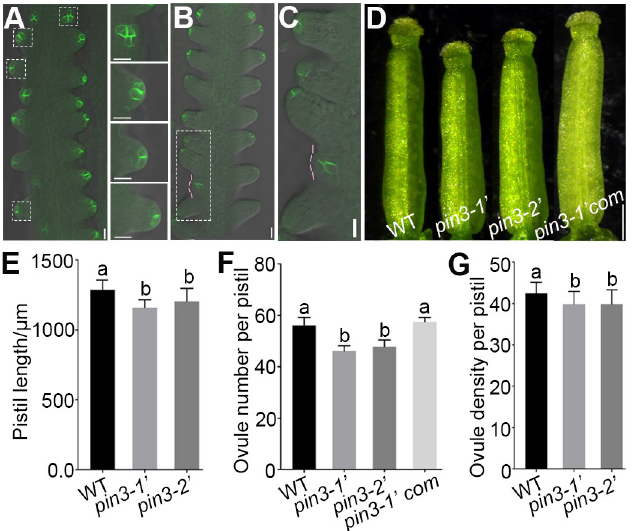
Fig 2. PIN3 functions in ovule primordia initiation. (A) PIN3 protein localization during ovule primordia initiation in pPIN3 :: PIN3-GFP line. Magnified views of the dashed squares from top to bottom in left panel are shown in right panel. (B-C) PIN3-GFP is detected in the young ovule primordia (stage 1-I) at floral stage 10. Magnified view indicated by dashed rectangle in (B) is shown in (C). Pink dashed lines represent the young ovule primordia. (D) Pistil image of the wild-type, pin3 mutants and the complementation line pPIN3 :: PIN3-GFP pin3-1’ (pin3-1’com ). (E–G) The pistil length (E), ovule number per pistil (F), and ovule density (G) of the wild-type, pin3 mutants and pin3-1’com . Data are presented as the mean ± SD (n = 21). Lowercase letters indicate significant differences revealed by one-way ANOVA (P < 0.01). Bars: 10 μ m (A-C) and 250 μ m